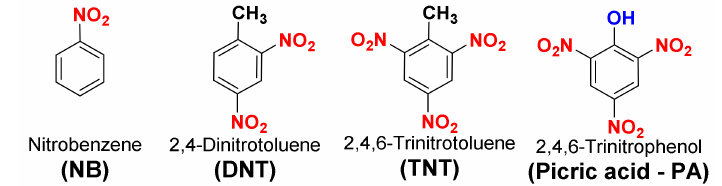
Figure 5. Structures of utilized nitroaromatic quenchers.